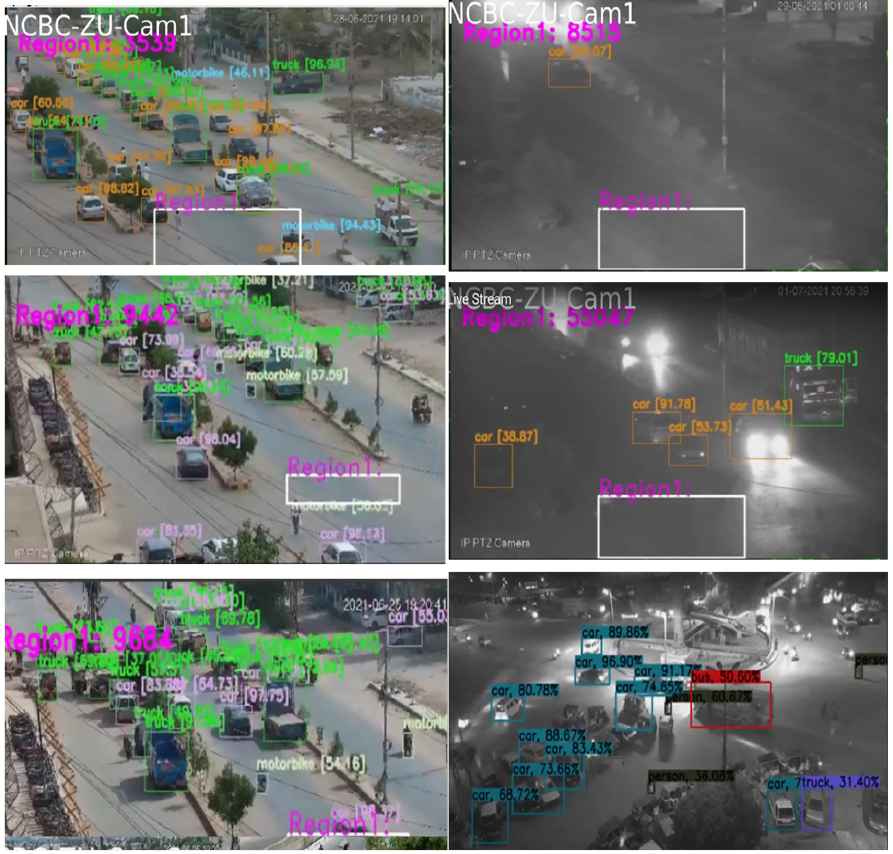
Figure 2. Detection and tracking of vehicles during